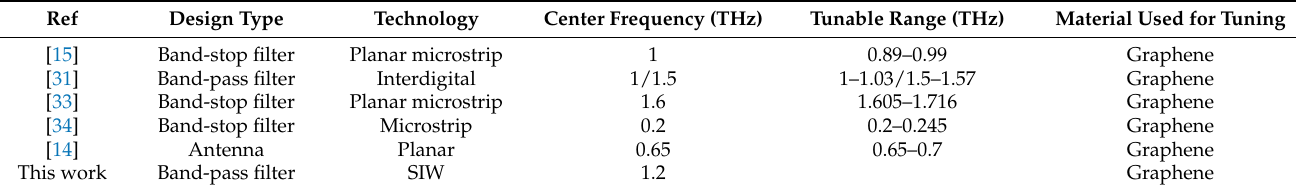
Table 3. Table of comparison with similar